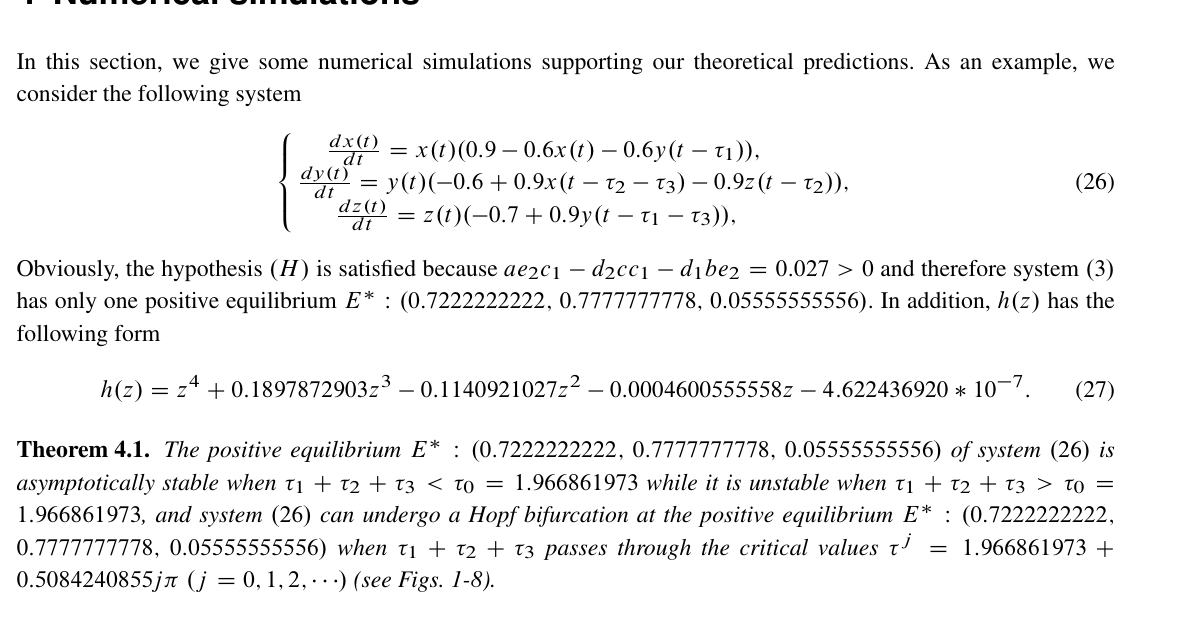
Fig. 1. The trajectory graph of system .26/ in t (cid:0) x plane with (cid:28) 1 D 0:5 , (cid:28) 2 D 0:4 and (cid:28) 3 D 0:3 . The initial value is .x.0/